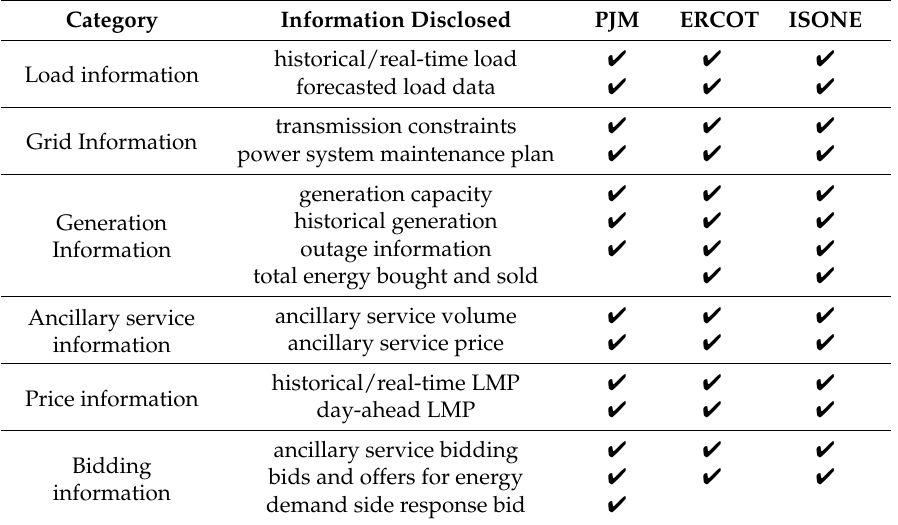
Table 3. List of information disclosed in PJM, ERCOT, and ISONE